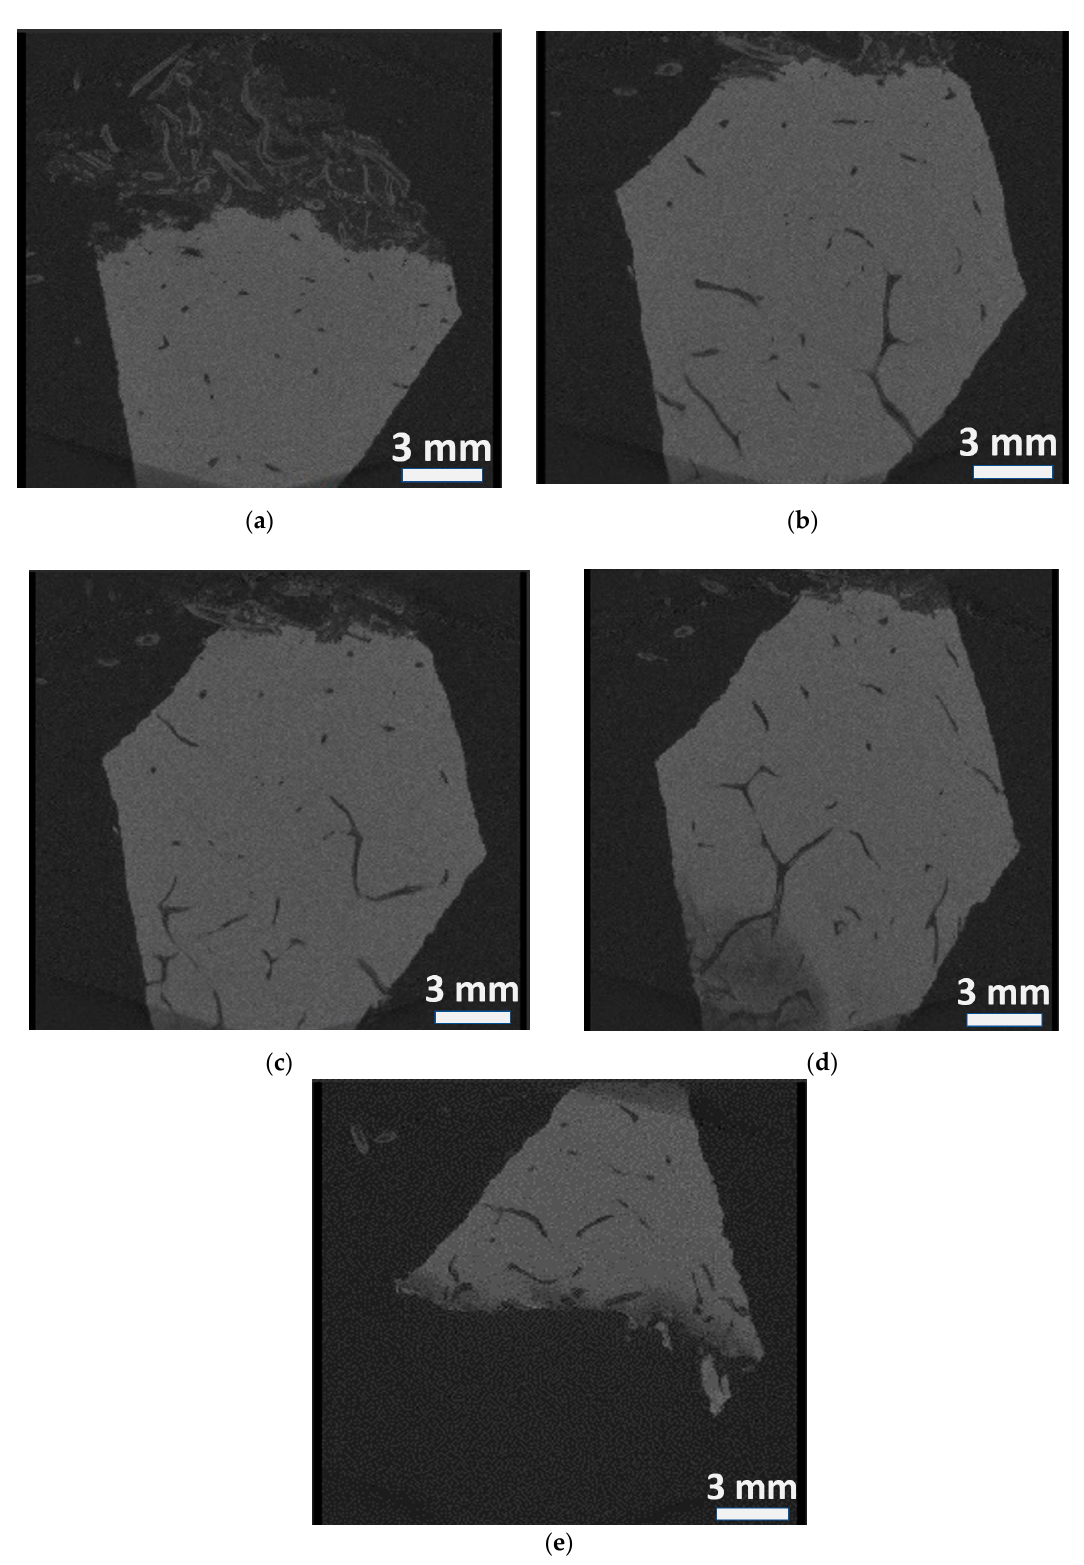
Figure 6. Horizontal (x-y plane) cross-sections of a coconut shell. ( a ) Top surface; ( b ) Horizontal middle 1; ( c ) Horizontal middle 2; ( d ) Horizontal middle 3; ( e ) Bottom